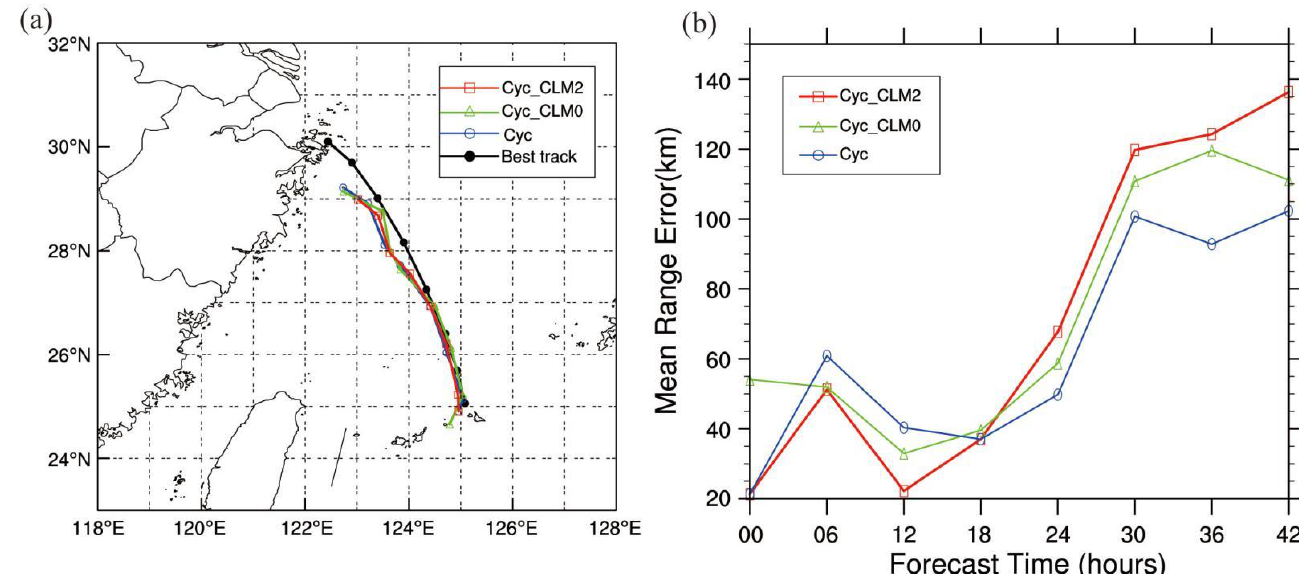
Figure 7. The 42 h predicted ( a ) tracks and ( b ) mean track errors (units: km) in the different experiments of Cyc (blue lines), Cyc_CLM0 (green lines), and Cyc_CLM2 (red lines) are compared to the CMA best-track data (black lines) from 1200 UTC 23 July 2021 to 0600 UTC 25 July 2021.